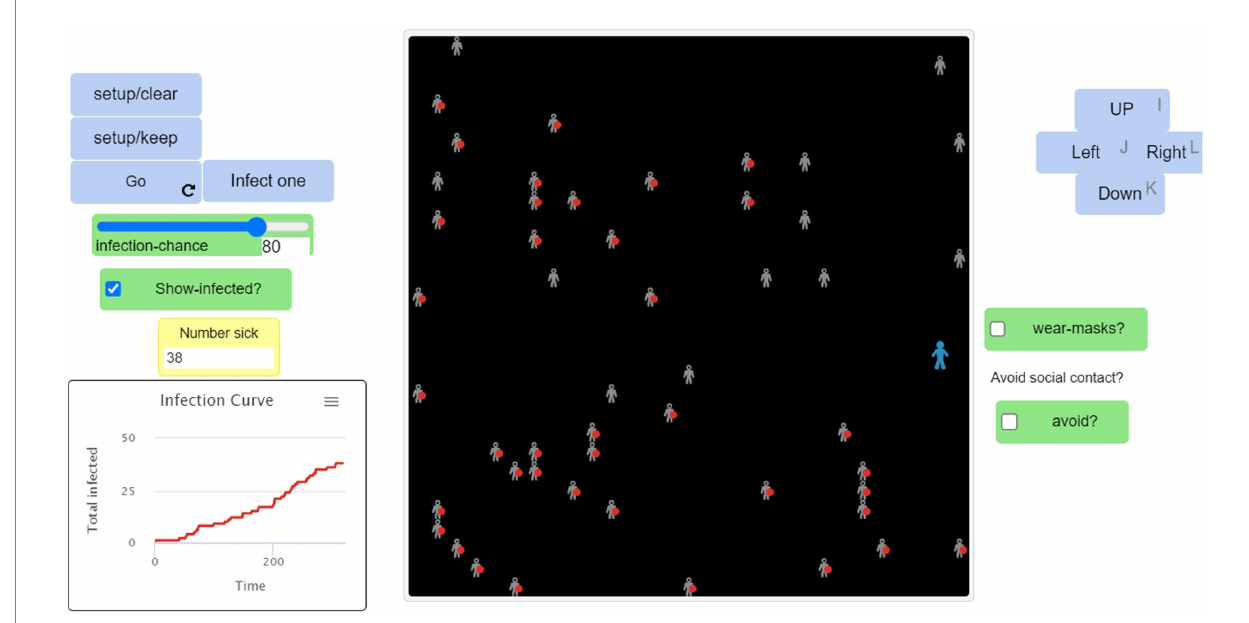
FIGURE 5 The adapted “Disease solo” participatory simulation. The user controls the blue agent. Agents with red dots are “infected” and those without are “healthy.” The graph shows the number of infected agents vs. time.